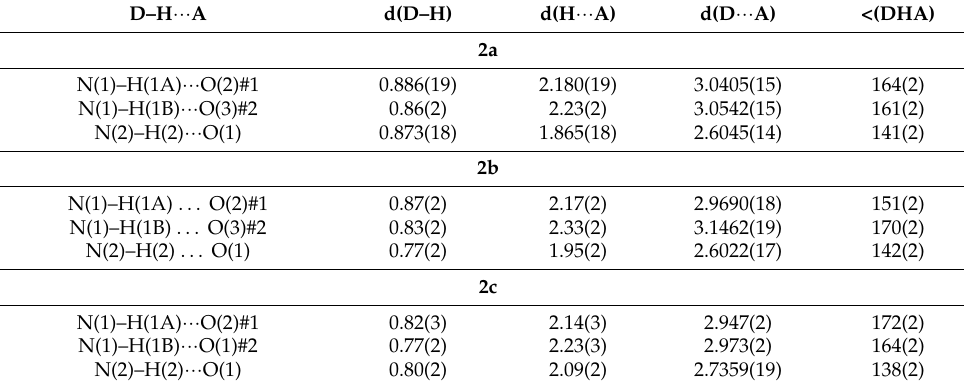
Figure 2. The Oak Ridge Thermal Ellipsoid Plot (ORTEP) diagrams and the X-ray crystal structure of 2a ( a ), 2b ( b ) and 2c ( c ) showing intra- and intermolecular hydrogen bonding. Table 2. Hydrogen bond geometries (Å and °) of compounds 2a , 2b and 2c .